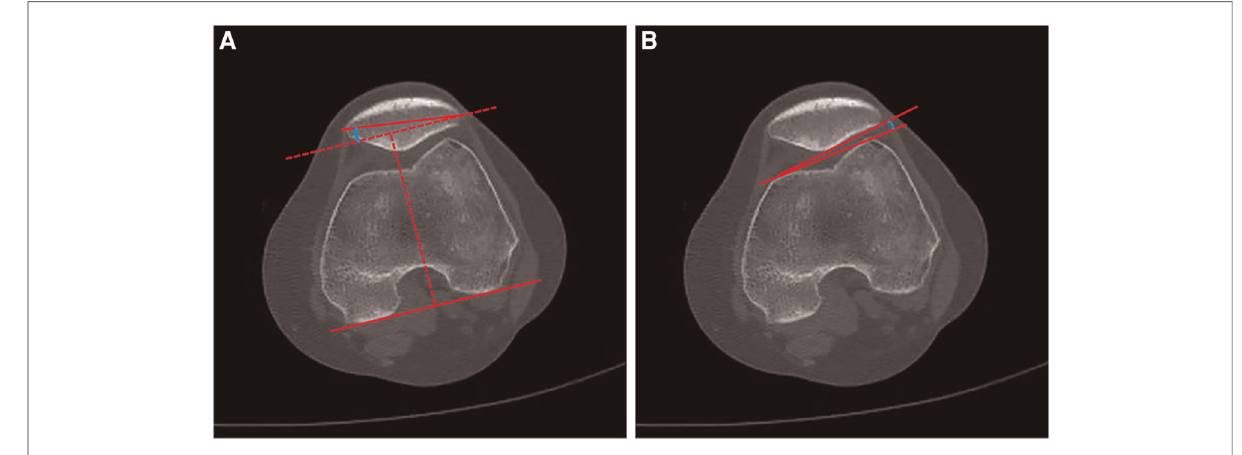
FIGURE 3 Schematic diagrams for PTA ( A ) and LPFA ( B